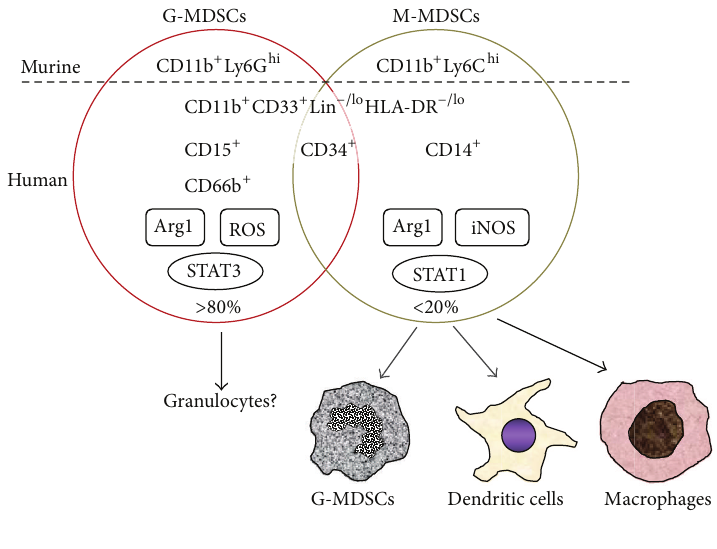
Figure 1: Surface markers and suppressive mechanisms of MDSCs. In murine cancer models, G-MDSCs (CD11b + Ly 6 G hi Ly 6 C lo ) and M- MDSCs (CD11b + Ly 6 C hi Ly6G − ) can be discriminated by the cell surface markers. However, identifying human MDSCs is still challenging because of their phenotypic heterogeneity and the absence of cognate surface markers in mice. Generally, human MDSCs can be defined as CD11b + CD33 + Lin −/ lo HLA-DR −/ lo andfurtherdividedtoCD15 + orCD66b + G-MDSCsandCD14 + M-MDSCs.Asubstantialpopulationshows both CD15 (or CD66b) and CD14 negative, suggesting that G-MDSCs and M-MDSCs are not completely distinct population. M-MDSCs can differentiate mature dendritic cells and macrophages or putatively